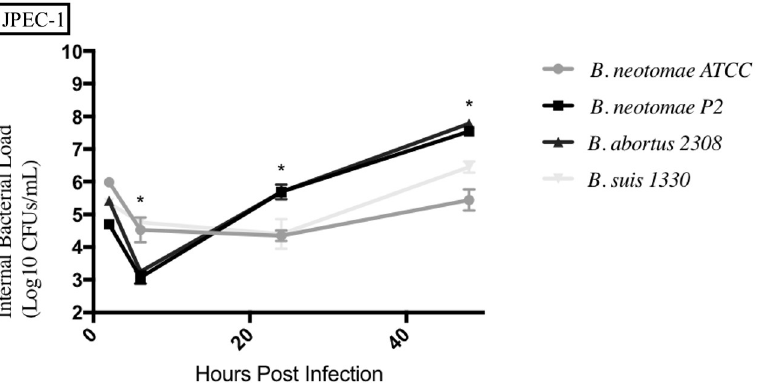
Fig 4. Intracellular survival of Brucella species in the swine jejunum epithelial cell line (JPEC-1). Intracellular Brucella spp. bacterial CFUs were determined over 48hrs in JPEC-1 as described. Error bars represent the standard deviation of the triplicates from a single experiment. � represents when intracellular CFUs from more than one species tested statistically differs from BN with any p value lower than